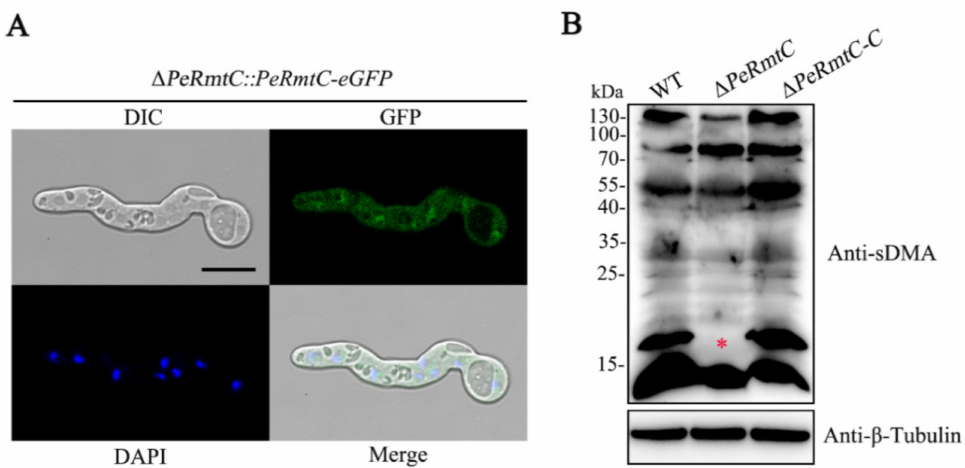
Figure 8. PeRmtC affects sDMA levels in P. expansum . ( A ) Subcellular localization of PeRmtC. DAPI, 4 (cid:48) , 6-diamidino − 2-phenylindole. DIC, differential interference contrast. The scale bar indicates 10 µ m. ( B ) Western blot analysis of symmetric ω - N G , N’ G -dimethylarginine (sDMA). Total proteins were extracted and immunoblotted with SYM10 antibody for sDMA and anti- β -Tubulin antibody for the loading control. A red asterisk marks the lost methylation signal in ∆ PeRmtC